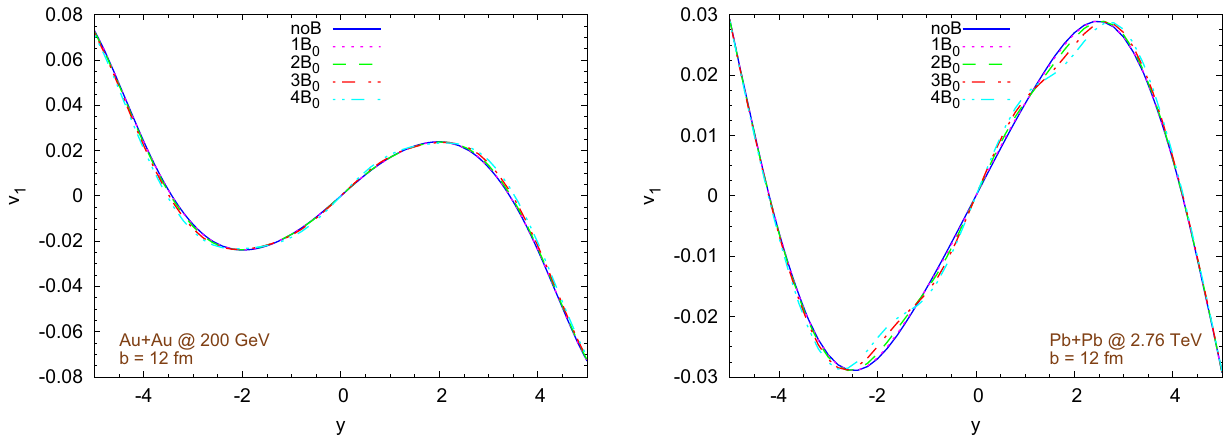
Fig. 4 Effect of the magnitude of the initial magnetic field on the directed flow v 1 vs rapidity y for peripheral collisions with b = 12fm. Left: √ s NN = 200GeV. Right: Pb+Pb collisions at Au+Au collisions at